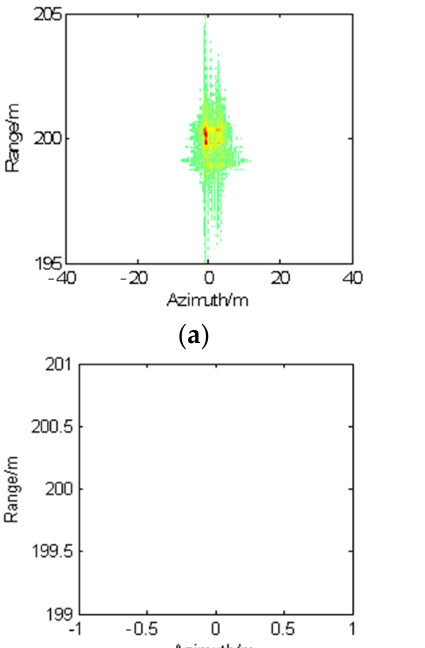
Figure 5. Comparison of range profiles of points 1 and 2. ( a ) Range profile of points 1 and 2 before RCMC; ( b ) RCMC results without using one-step MOCO method; ( c ) RCMC results after one-step MOCO method.